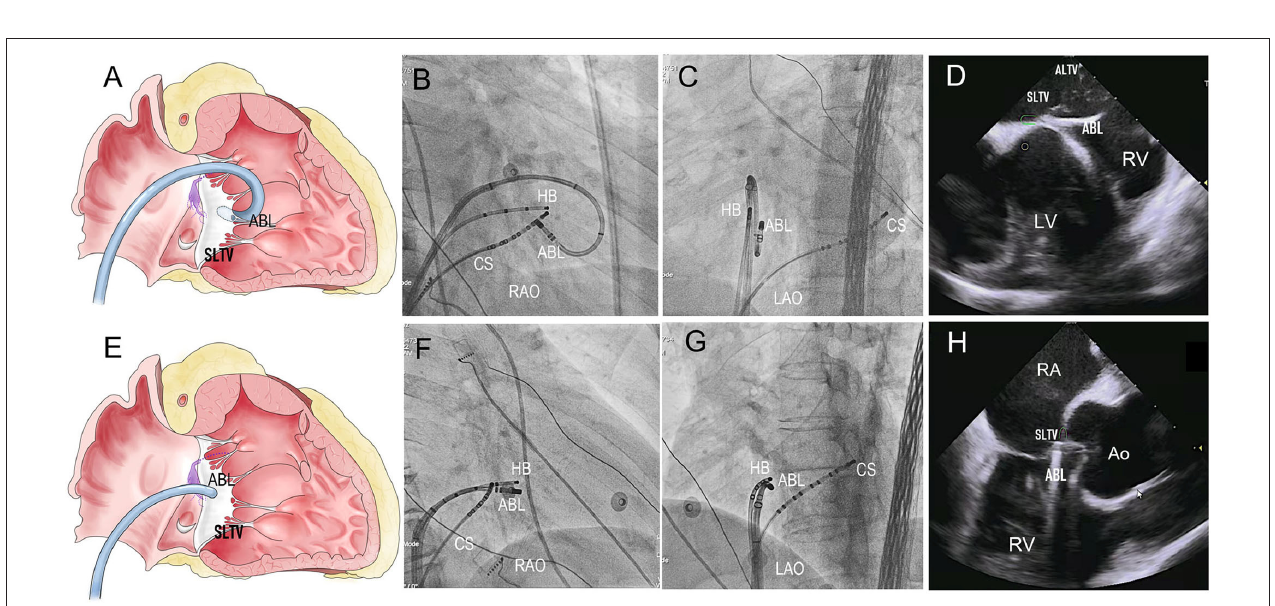
FIGURE 1 | Examples of PHVA electrocardiograms and the flow chart of the systemic mapping approach. (A) Typical twelve-lead electrocardiographic manifestation of parahisian VAs. Right parahisian VAs were diagnosed in Case 1–5, and left parahisian VA in Case 6. Note there were positive “R” waves/or QRS discordance in inferior leads, a “QS” wave in lead V1, precordial transition in lead V2–V4 for right parahisian VAs, and a “qR” wave in lead V1 and precordial transition in lead V1–V2 for left parahisian VA. (B) The flow chart of the systemic mapping approach for right and left parahisian VA.